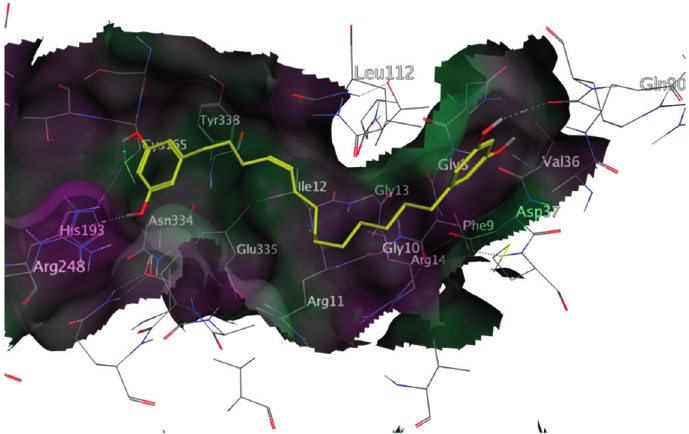
Figure 5. Lowest energy docking pose of compound NP-014428 ( 5 ) (yellow) in the NAD + binding site of Tb GAPDH (PDB-ID 2X0N) (co-crystallized NAD + not shown); rendered surface colored according to lipophilicity, green indicating high, purple low